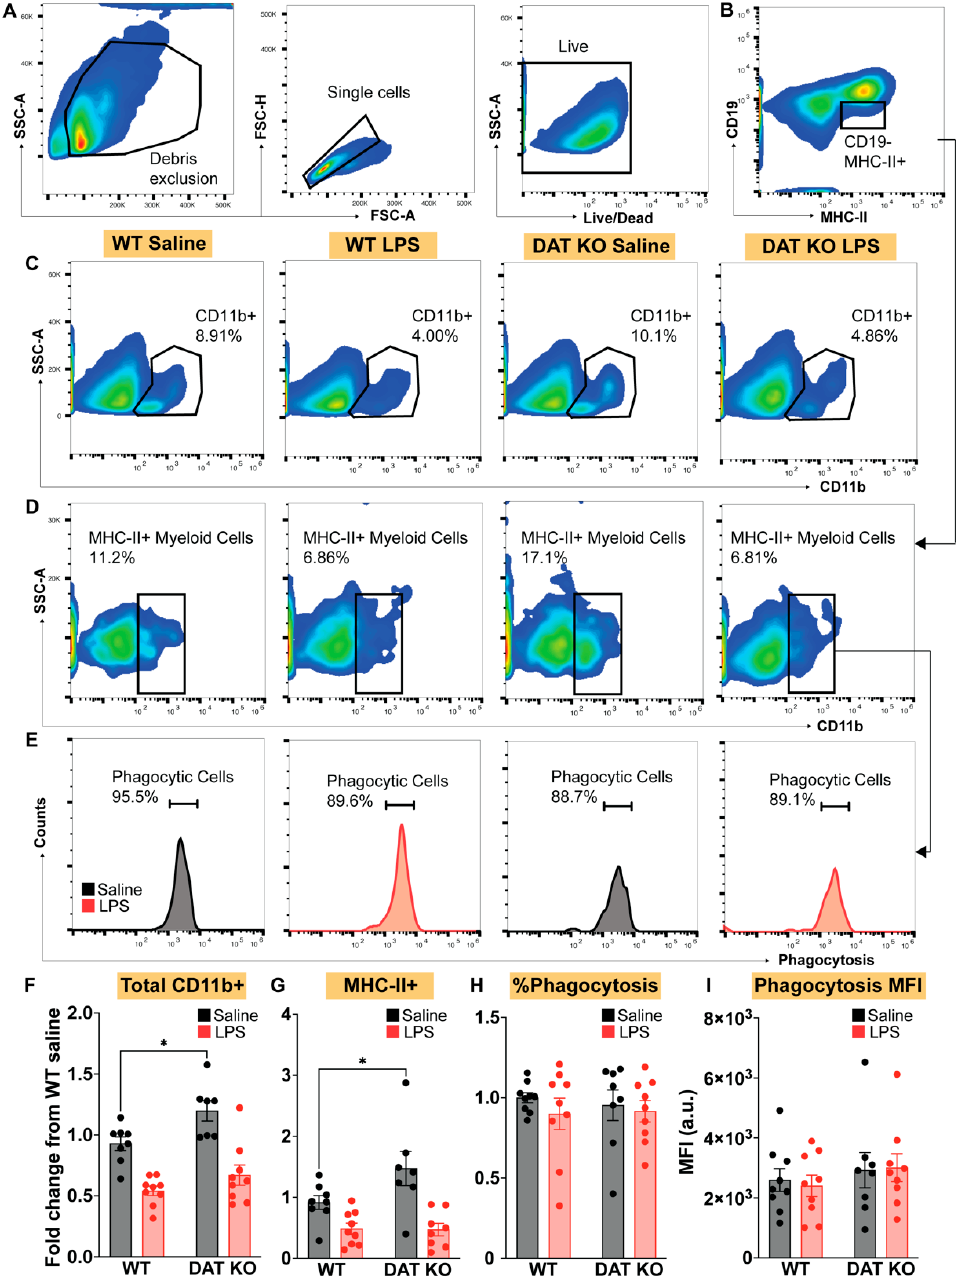
Figure 5. In DAT − / − mice, splenic myeloid cells are increased and show exaggerated MHC-II expression but exhibit no changes in total phagocytosis in response to LPS. ( A ) After excluding debris, cell aggregates and dead cells, total live cells were analyzed for expression of CD11b ( C ). At baseline, DAT − / − animals exhibit increased CD11b+ myeloid cells ( C , F ). Cells gated to include only MHC-II expressing CD11b+ myeloid cells ( B , D ) revealed increased baseline MHC-II expression in DAT − / − mice compared to WT controls, in the absence of LPS treatment, indicating increased antigen presentation capacity in DAT − / − mice ( G ). However, in contrast to peritoneal macrophages, splenic myeloid cells show no changes in phagocytic response to endotoxin challenge ( E , H ), suggesting that presence or absence of DAT differentially impacts immune function in peripheral immune organs in DAT − / − animals. (Two-way ANOVA with Sidak’s correction for multiple comparisons; n = 6–9 per group. * p < 0.05). ( I ). The relative amount of phagocytosis per macrophage across genotypes and treatment conditions